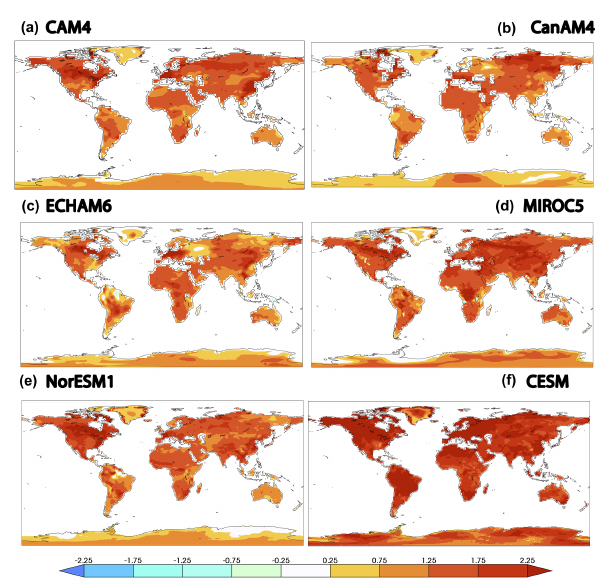
Figure 3. Change in 20-year return values ( ◦ C) between the 2.0 ◦ C and present-day HAPPI simulations of TX3x. (a) CAM4. (b) CanAM4. (c) ECHAM6. (d) MIROC5. (e) NorESM1. (f) CESM.